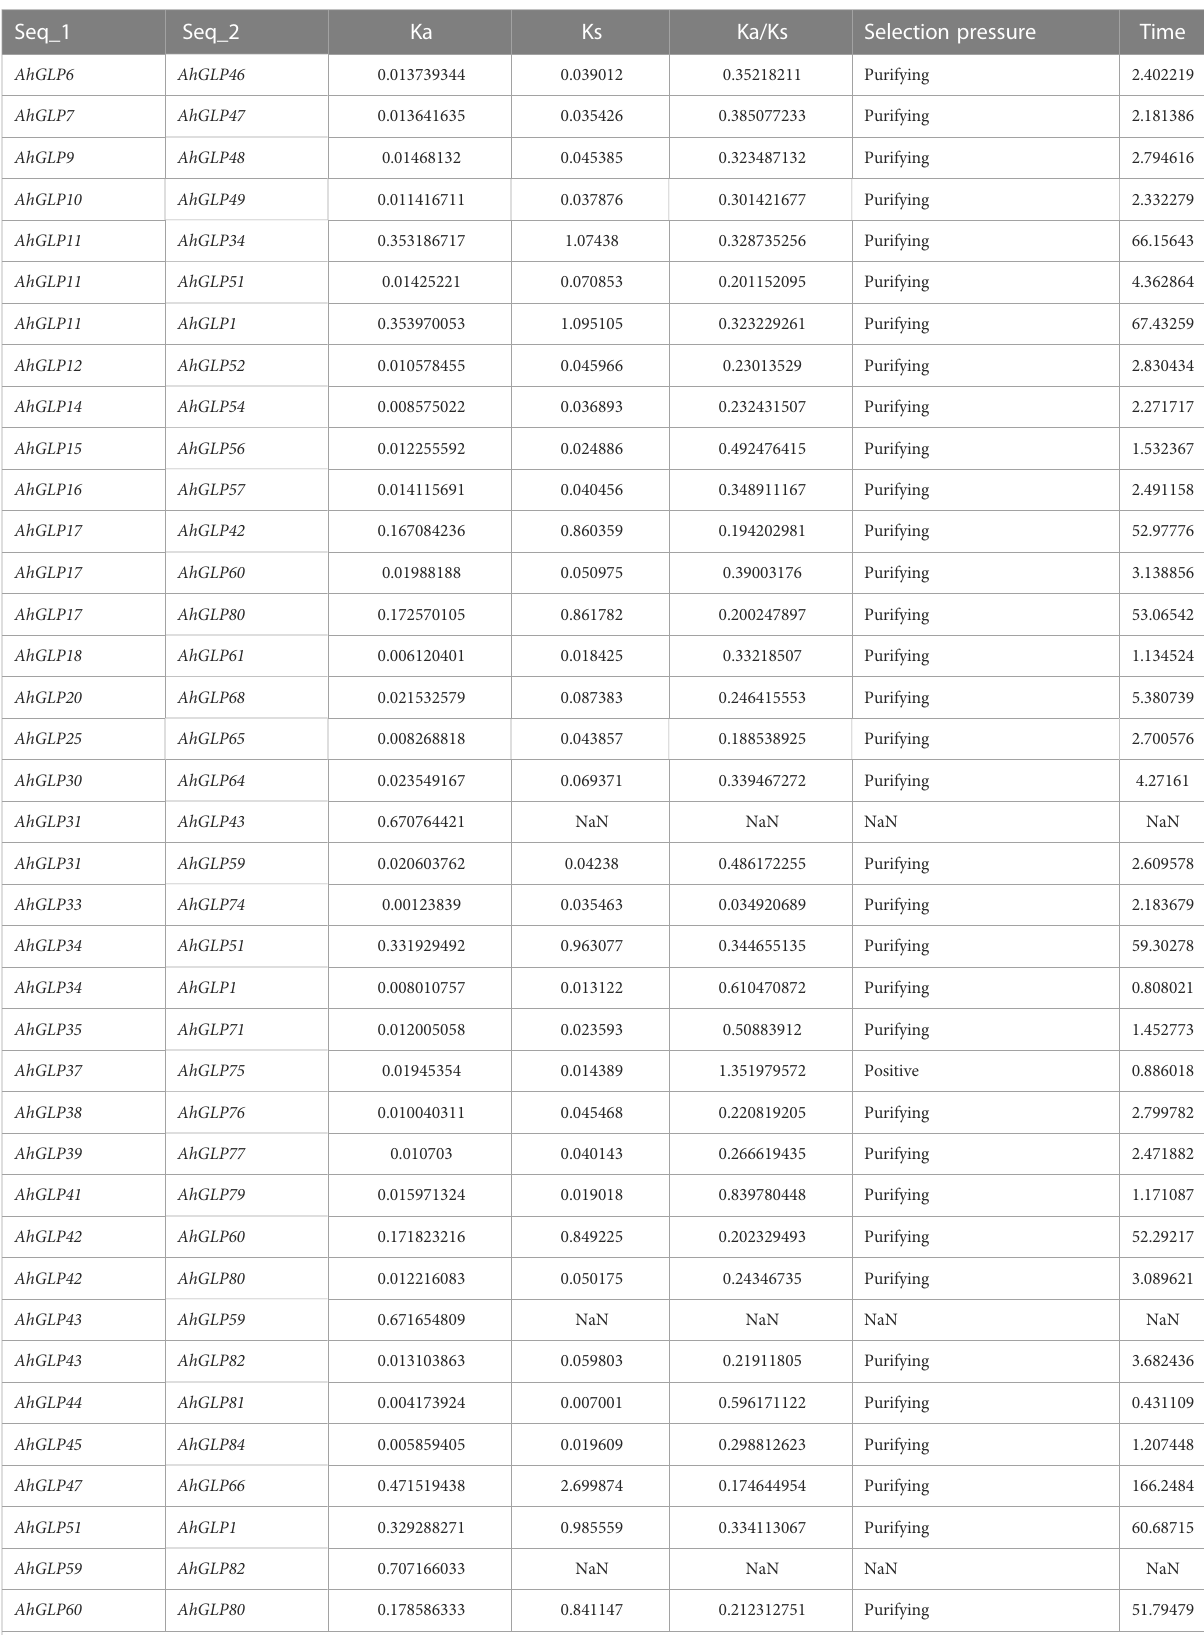
TABLE 2 Identi fi cation of duplicated gene pairs among AhGLPs and their expected divergence